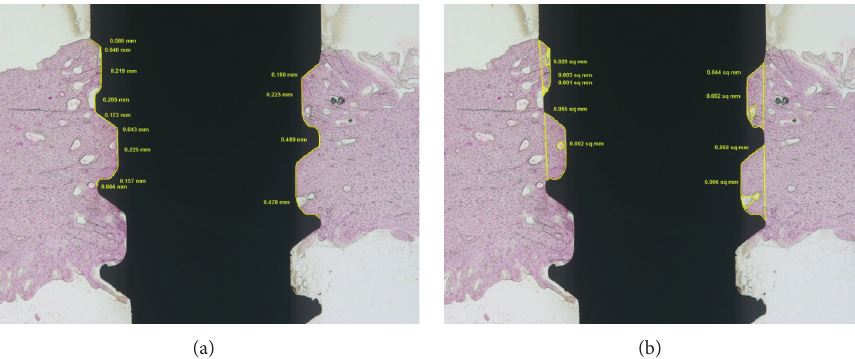
Figure 4: Histologic measurements. (a) Bone to implant contact, the percentage of linear surface of the implant directly contacted by mineralized bone (BIC%). (b) Bone density, the percentage of mineralized bone over the total tissue volume (BV/TV%).